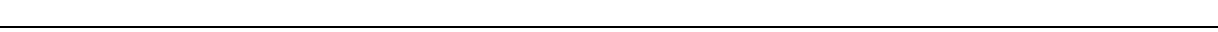
Fig. 2 KSRP exhibits different functions during monocytic and granulocytic differentiation. a , b Immunoblot analysis of KSRP protein in CD34 + HPC models of monocytic and granulocytic differentiation from cord blood a or bone marrow b . c qPCR analysis of KSRP mRNA in THP-1 and HL-60 cells undergoing monocyte differentiation (left), and in NB4 and HL-60 cells undergoing granulocyte differentiation (right). Three technical replicates from a single experiment representative of two independent experiments. d Immunoblot analysis of KSRP expression as indicated in c . e qPCR detection of the KSRP , CD14 and CD11b levels in CD34 + HPCs transduced with lenti-sh_KSRP or lenti-scramble control during monocytic and granulocytic differentiation. Three technical replicates from a single experiment. f CD34 + HPCs were infected with lenti-sh-KSRP or lenti-scramble, followed by M-CSF stimulation. Left: FACS analysis of the CD14 + /CD11b + cells in GFP + and GFP − cells; The ratio of CD14 + /CD11b + cells in GFP + to that in GFP − was shown in the right (parentheses means the normalized ratio to the control); right: May-Grunwald Giemsa staining and the statistical analysis of the percentages of monoblasts (Mob), promonocytes (PMo), monocytes (Mo) and macrophages (Ma). g CD34 + HPCs were infected with lenti-sh-KSRP or lenti-scramble, followed by G-CSF stimulation. Left: FACS analysis of the CD11b + cells in GFP + and GFP − cells; The ratio of CD11b + cells in GFP + to that in GFP − was shown in the right; right: May-Grunwald Giemsa staining and the statistical analysis of the percentages of myeloblasts (Mb), promyelocytes (Pb), metamyelocytes (MM) and band & segmented neutrophils. Magni fi cation, 40×. The bar represents 10 μ m. h Colony-forming assays of CD34 + HPCs and the statistical analysis of CFU-M and CFU-G. Three technical replicates from a single experiment. The bar represents 50 μ m. i Immunoblot analysis of the KSRP protein in THP-1 and NB4 cells transduced with pSIH-sh-KSRP or the pSIH control. j Quantitation of the FACS results showing CD14 expression during monocytic differentiation of THP-1 cells transfected with sh-KSRP or pSIH control (upper), and CD11b expression during granulocytic differentiation of NB4 cells transfected with sh- KSRP or pSIH control (lower). Three technical replicates from a single experiment representative of two independent experiments. Data are shown as means ± s.d. * P < 0.05, ** P < 0.01, *** P < 0.001, Student ’ s t